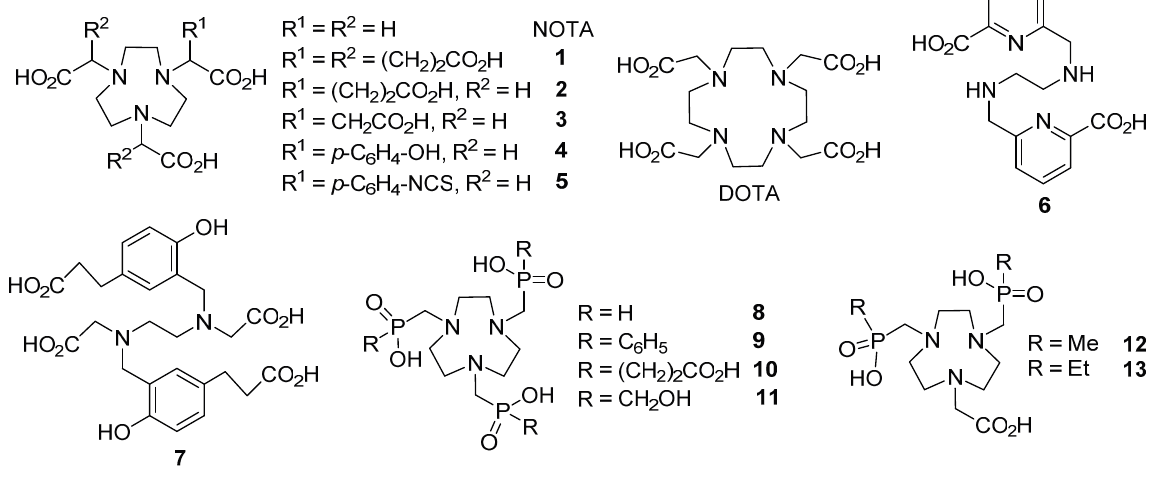
Figure 1. Macrocyclic and open-chain chelators for trivalent gallium.